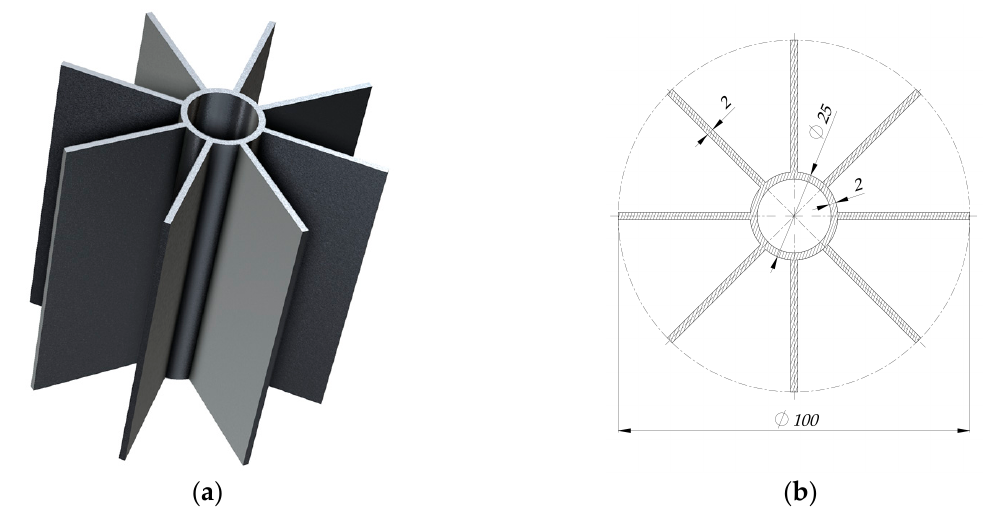
Figure 5. ( a ) Geometry and ( b ) cross-sectional dimensions of longitudinal finned tube with 8 fins.